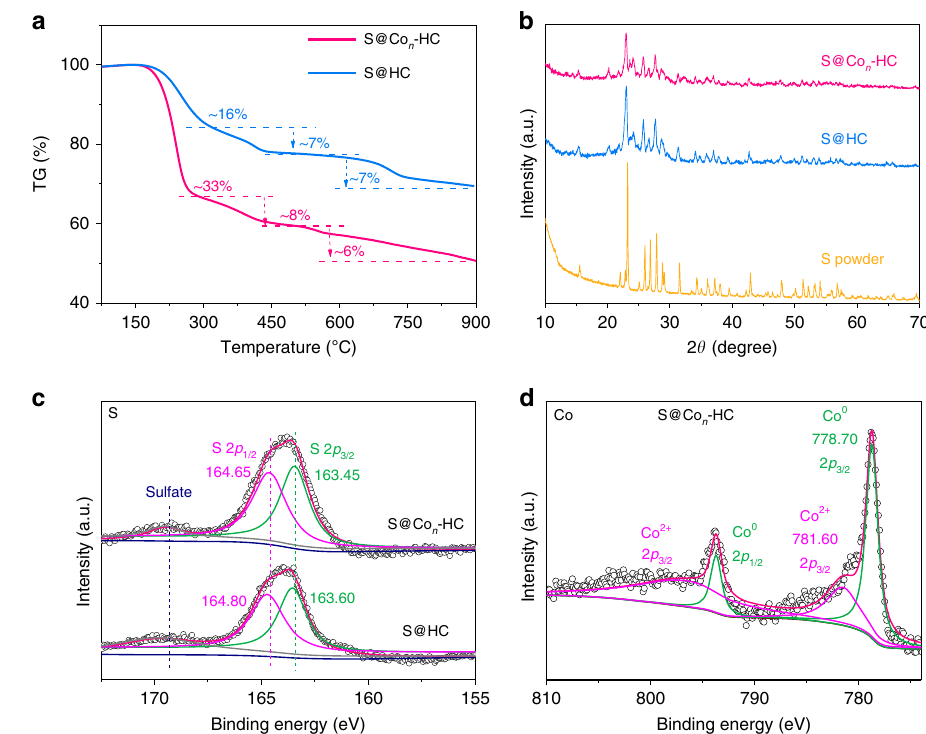
Fig. 3 Thermogravimetric analysis, X-ray diffraction, and X-ray photoelectron spectra. a Thermogravimetry (TG) of hollow carbon hosting sulfur (S@HC) and atomic cobalt-decorated hollow carbon sulfur host (S@Co n -HC). b X-ray diffraction (XRD) patterns of sulfur (S) powder, S@HC and S@Co n -HC. c S 2 p region of X-ray photoelectron spectroscopy (XPS) spectra for S@HC (bottom) and S@Co n -HC (top). d Co 2 p region of XPS spectrum for S@Co n